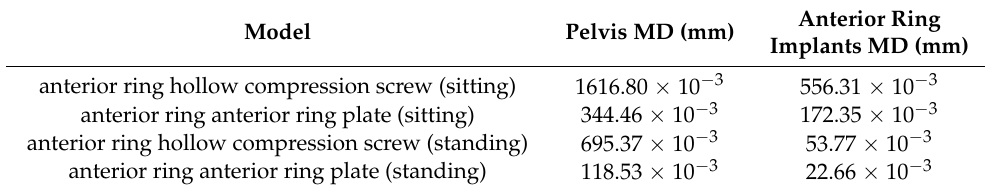
Table 3. The maximum displacement (MD) of different finite element models after loading the pelvis.